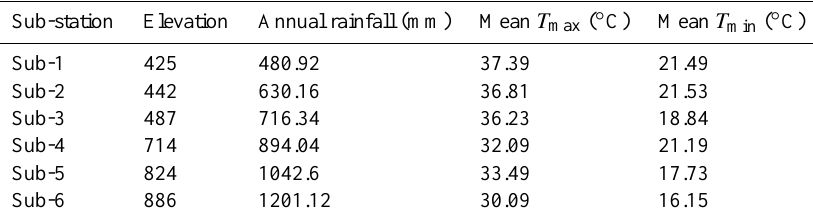
Figure 4. SWAT simulated and observed monthly streamflow in Al Gwisi gauge during the calibration period (1989–1993) (lift panel) and validation period (1995–1999) (right panel); Obs indicates the observed flow and Sim indicates the simulated flow. Table 3. Statistics of climate stations for the period of 1961–1990 in the DRB.